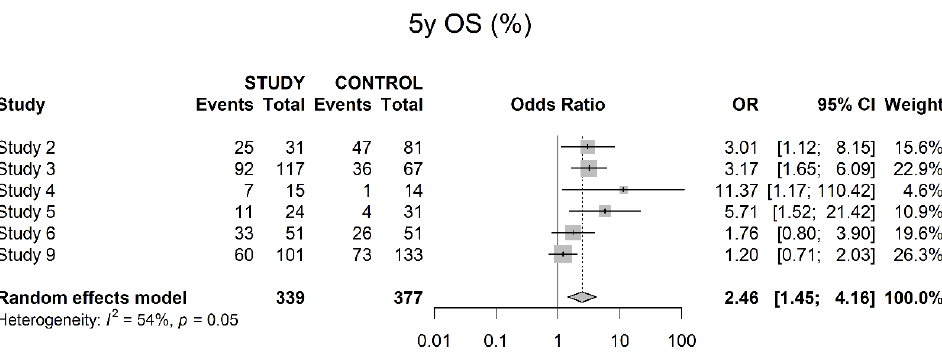
Figure 12. Five-year overall survival.